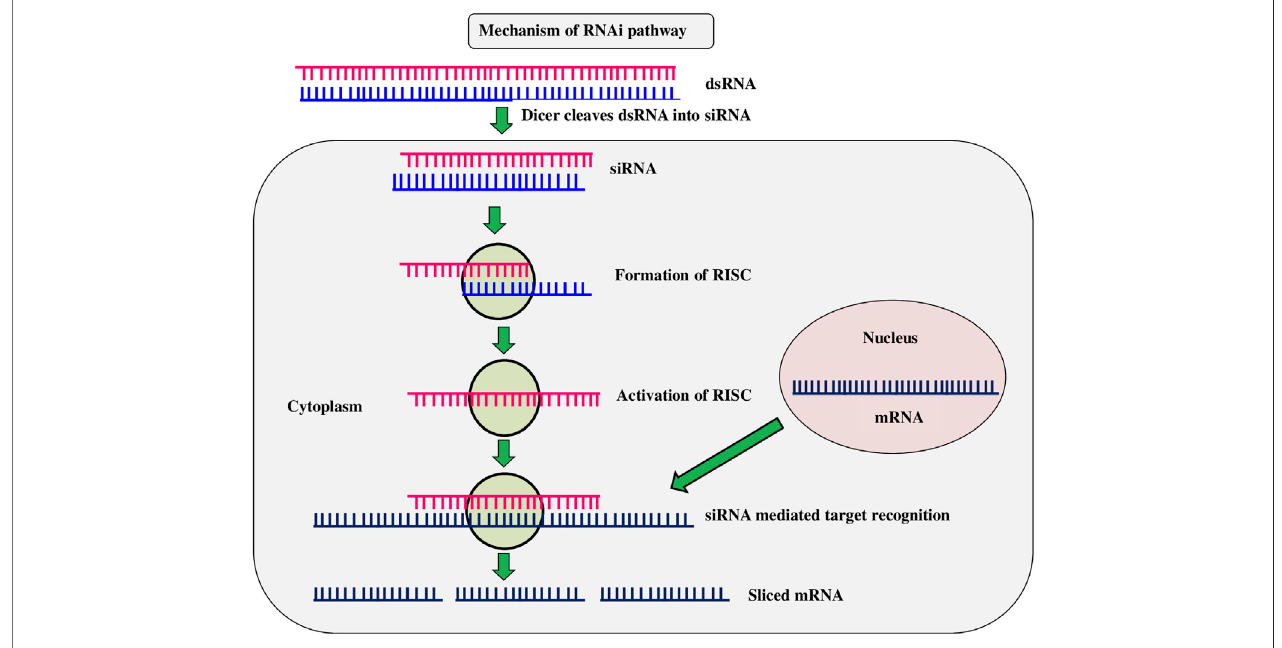
FIGURE 5 | RNA interference